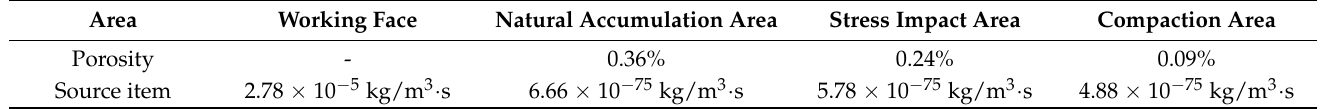
Table 1. Parameters of each area.